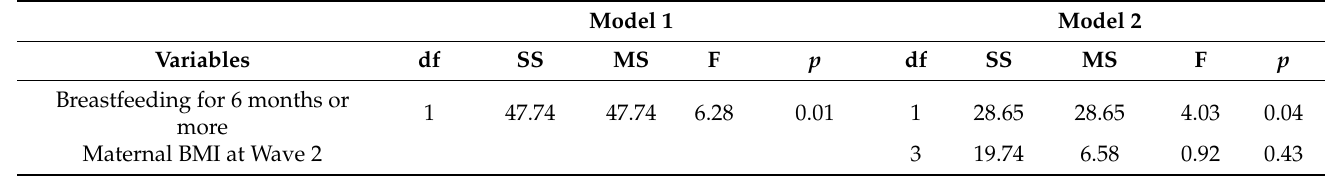
Table 3. Analysis of covariance of breastfeeding for 6 months or more and maternal depressive symptoms from Wave